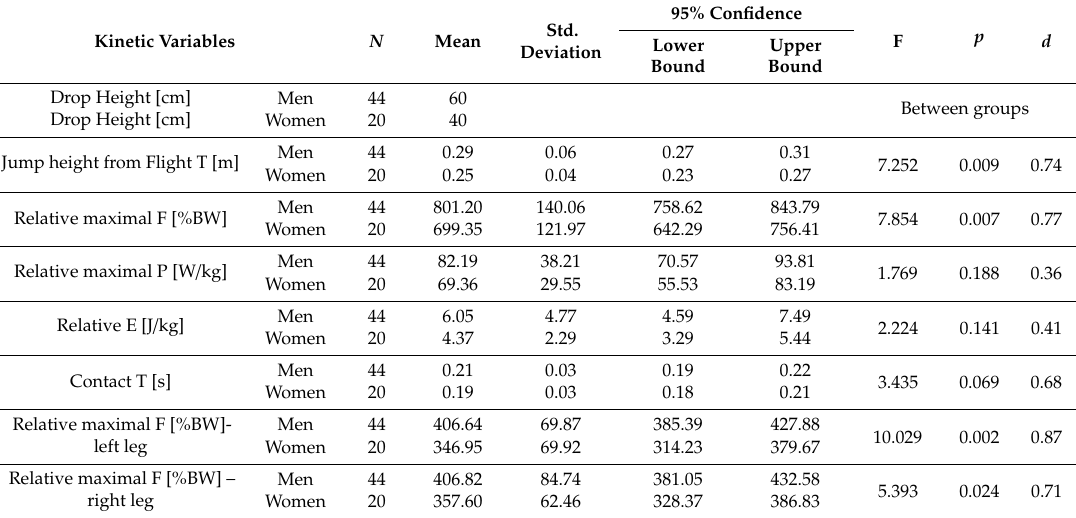
Table 3. Descriptive statistics of selected kinetic variables of CMJ during drop jumps from 30 cm (female) and 60 cm (male) athletes.